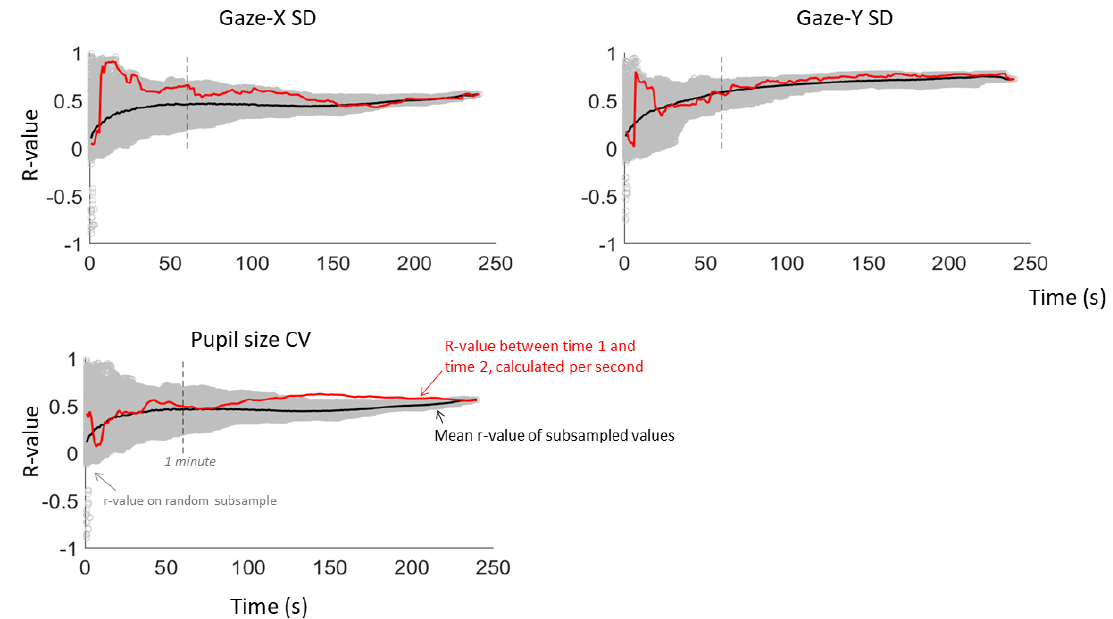
Figure 5. Intra-individual reliability of Experiment 1 over the course of the resting state for our three continuous measures: gaze variability (in the horizontal and vertical dimension) and pupil size mean and variability. The r-value between time points 1 and 2 was calculated at each cumulative second (red), thus reflecting the trajectory over time. Next, for each cumulative second, estimates of the r-value were calculated on 1000 random subsamples. These estimates are shown in light-grey circles, with the mean of these subsamples shown in